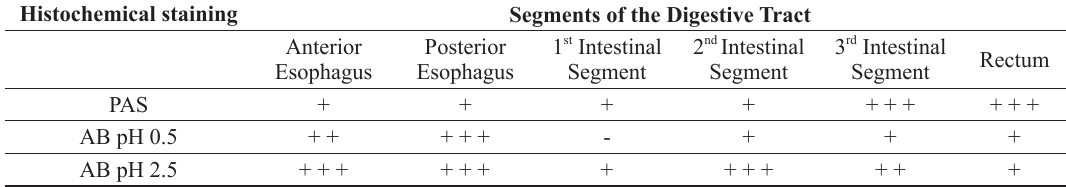
Reaction intensity histochemical rating of PAS and AB pH 0.5 and 2.5 of the mucosa of the segments of the digestive tract of puffer fish Sphoeroides testudineus .